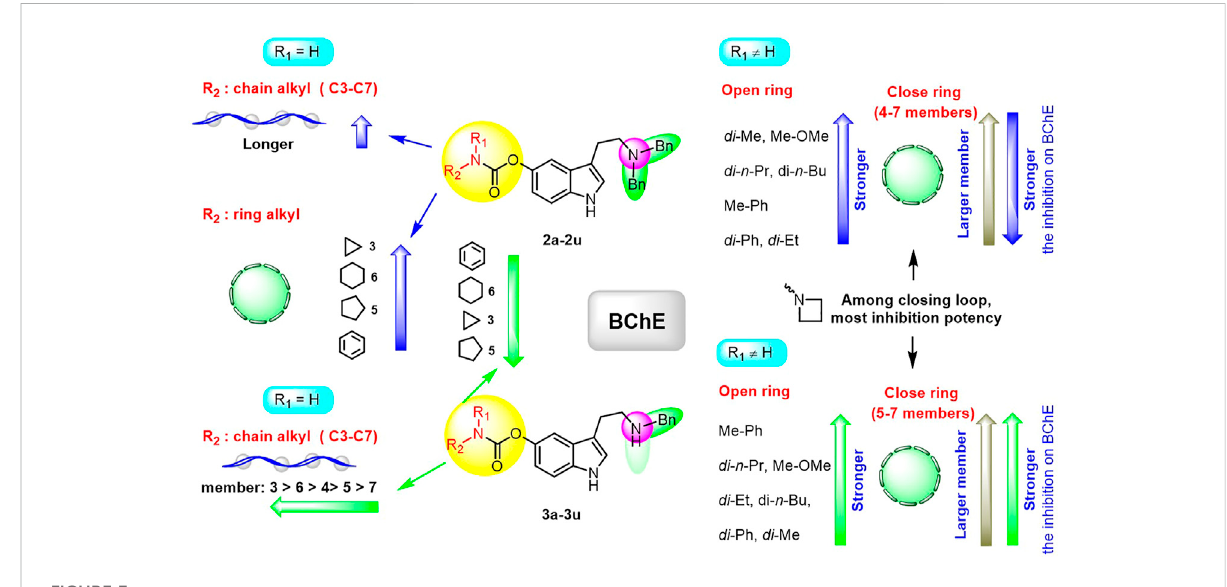
FIGURE 3 Outline of SARs of compounds 2a-2u and 3a-3u on BuChE.